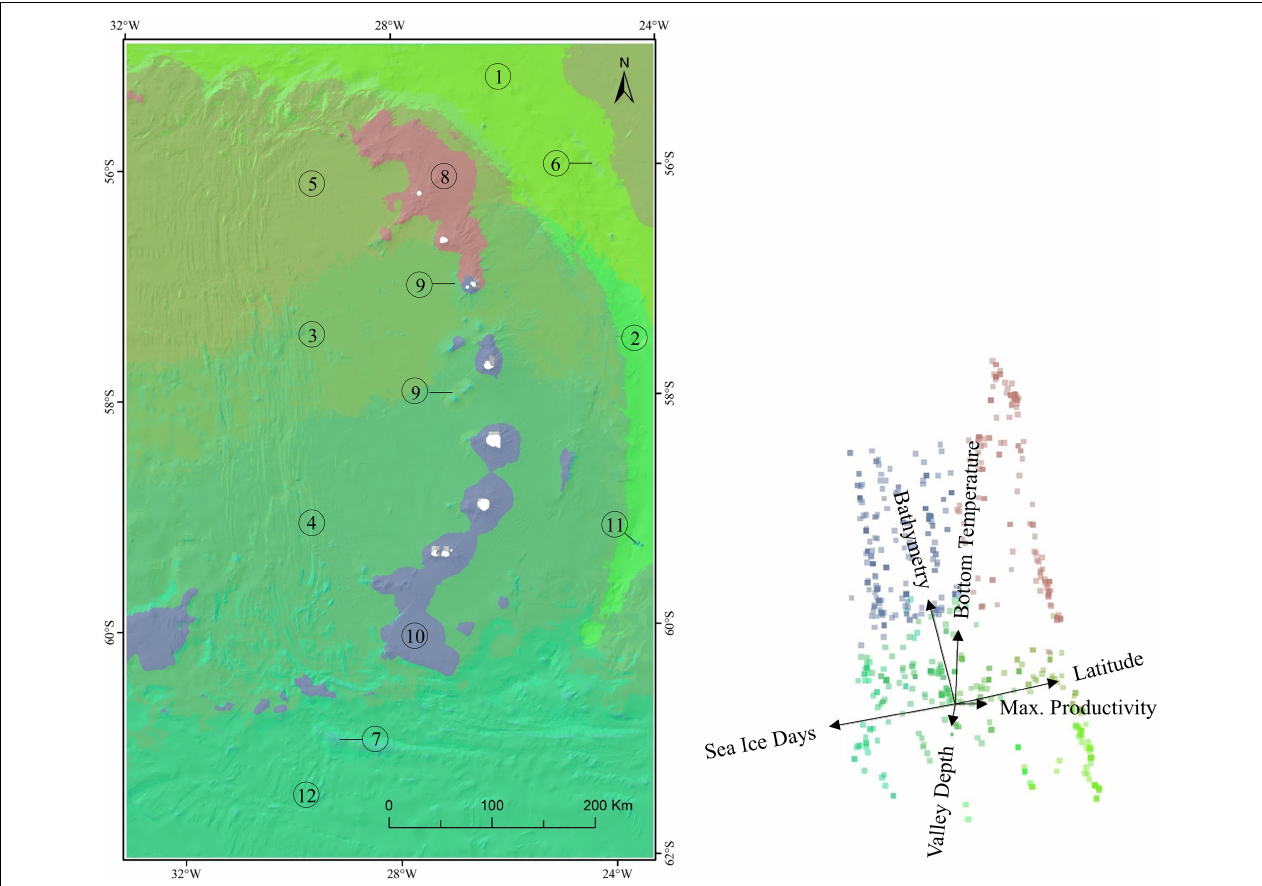
FIGURE 7 | Gradient forest mapping clusters combining transformed environmental variables with benthic functional group data. Clusters represent the expected continuous patterns of composition for seabed biodiversity at the South Sandwich Islands with similarity in composition denoted by similarity in colour. The biplot shows the first two principal dimensions of the biologically transformed environment space with vectors indicating the direction and magnitude of major environmental drivers and colours corresponding to mapping clusters. Mapping clusters are numbered and correspond with clustering classes shown in Supplementary Figures 3, 4